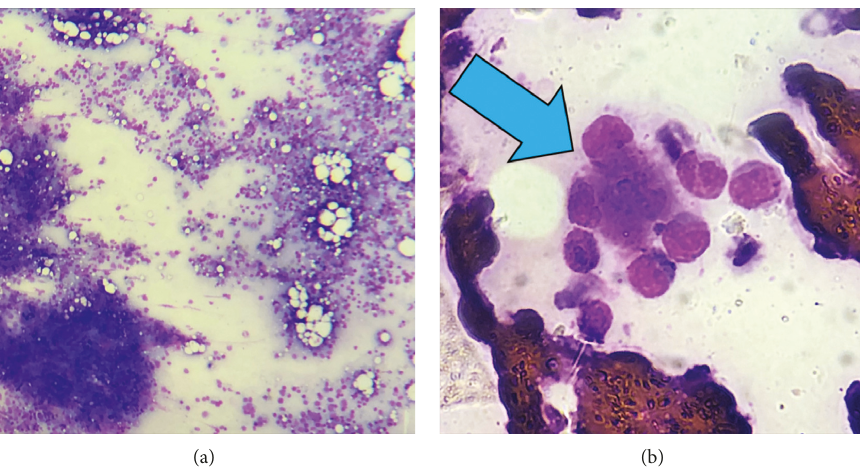
Figure 1: BMA smear. Normocellular marrow with trilineage hematopoiesis (a). Phagocytosis (blue arrow) by a histiocyte of erythroids and granulocytes (b).